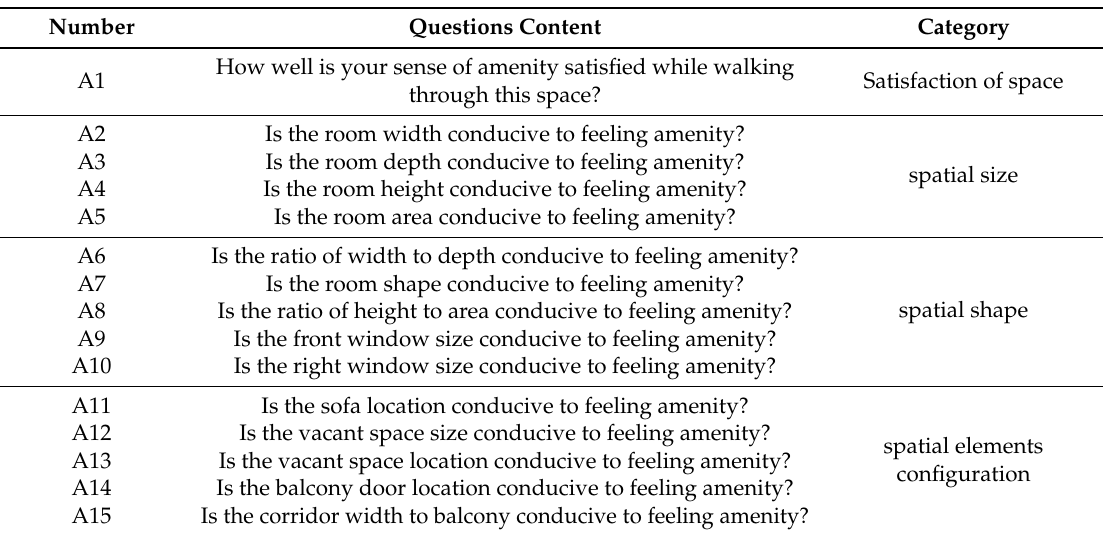
Table 3. Contents of questionnaire for amenity